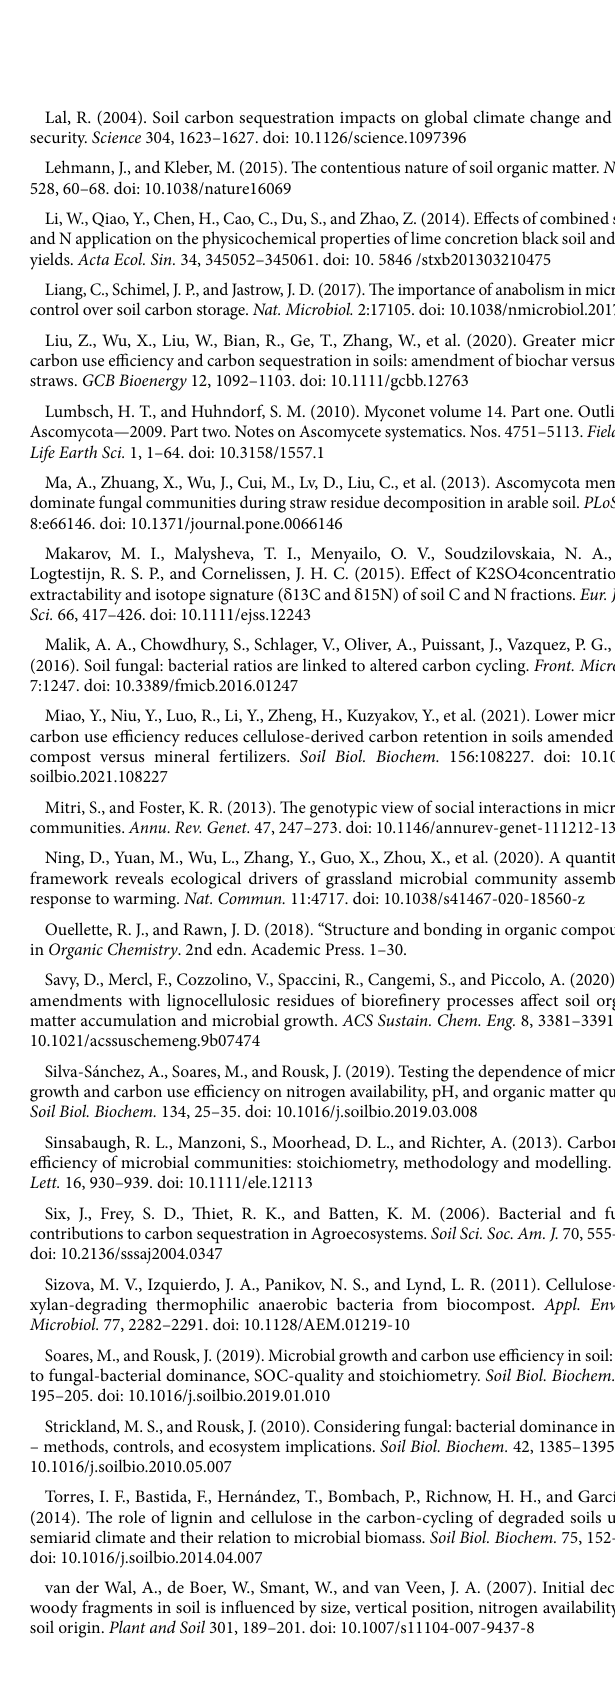
dominant OAs), MM (Addition of OAs with equal content of lignin and cellulose), and CM (Addition of cellulose-dominant OAs). SUPPLEMENTARY FIGURE S3 Effects of Alic_C, Alip_C, Arom_C, and Hete_C on fungal-to-ratios, cbhI-to- GH48 ratios, diversity and abundance of bacteria and fungi, dominant